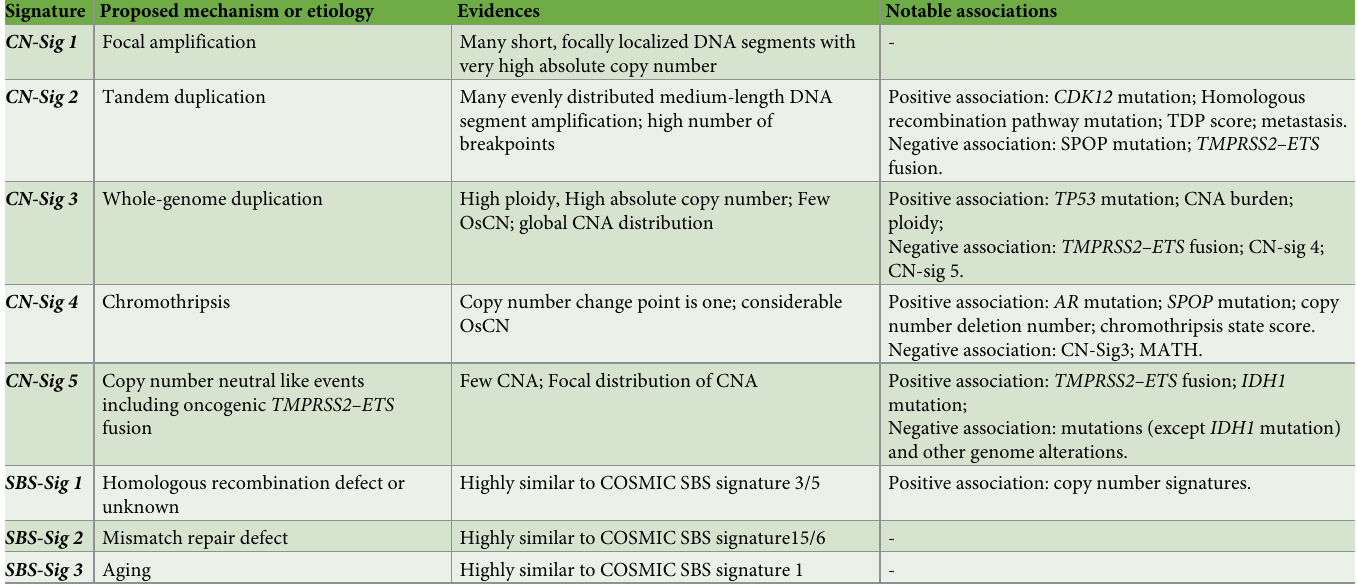
Table 1. Genome alteration signatures in PC. Associations for each genome alteration signature and proposed mechanisms are shown. Signature Proposed mechanism or